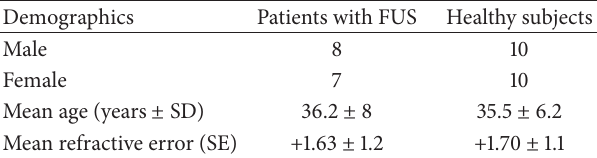
Table 1: Demographic data of patients and healthy